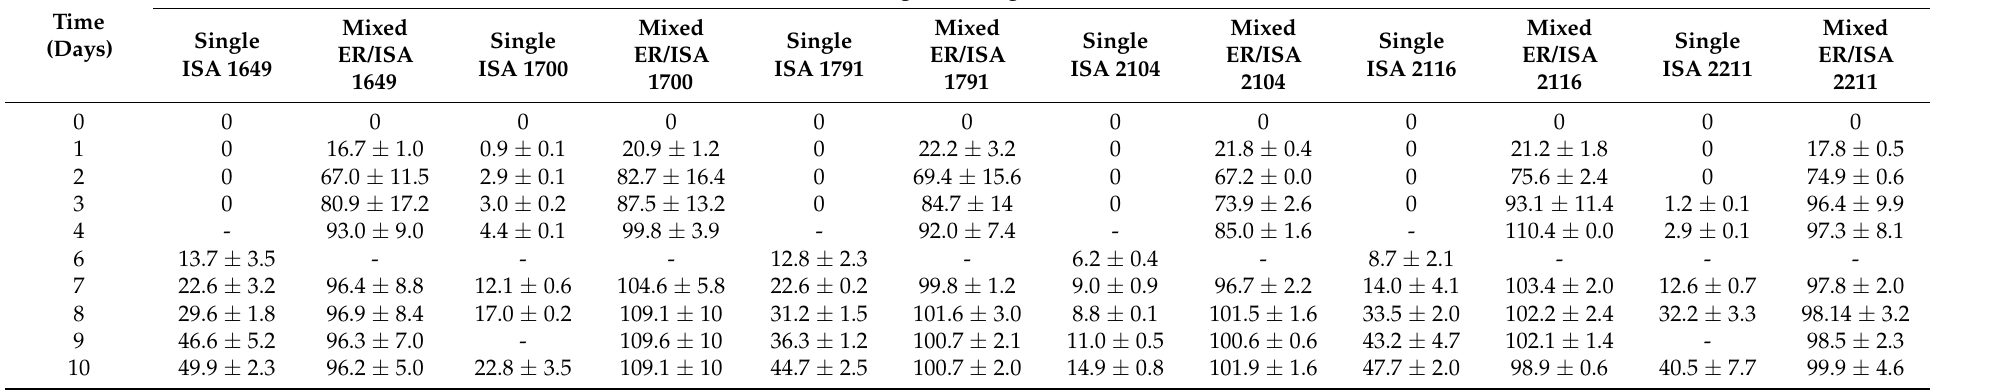
Table 2. Ethanol production during alcoholic fermentations performed with the B. bruxellensis strains ISA 1649, ISA 1700, ISA 1791, ISA 2101, ISA 2116 and ISA 2211 in single-culture and in mixed-culture with S. cerevisiae Ethanol Red (ER). Data presented correspond to means ± SD of two independent biological assays, each analyzed in